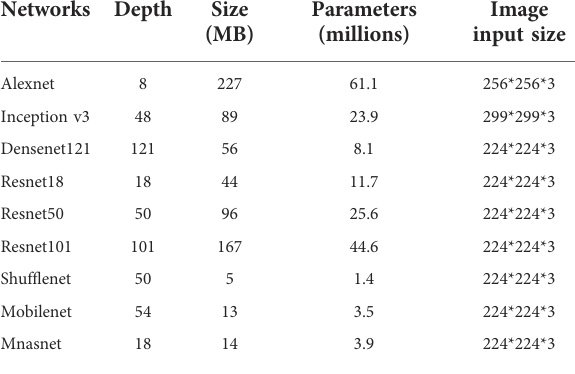
TABLE 1 The properties of the convolutional neural